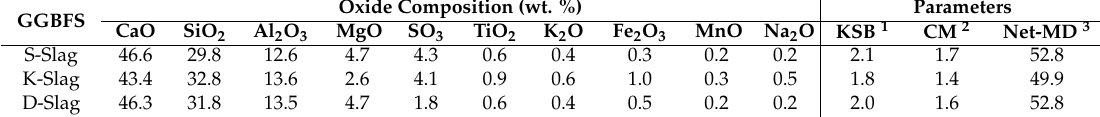
Table 2. Chemical compositions of raw GGBFSs from XRF analysis.